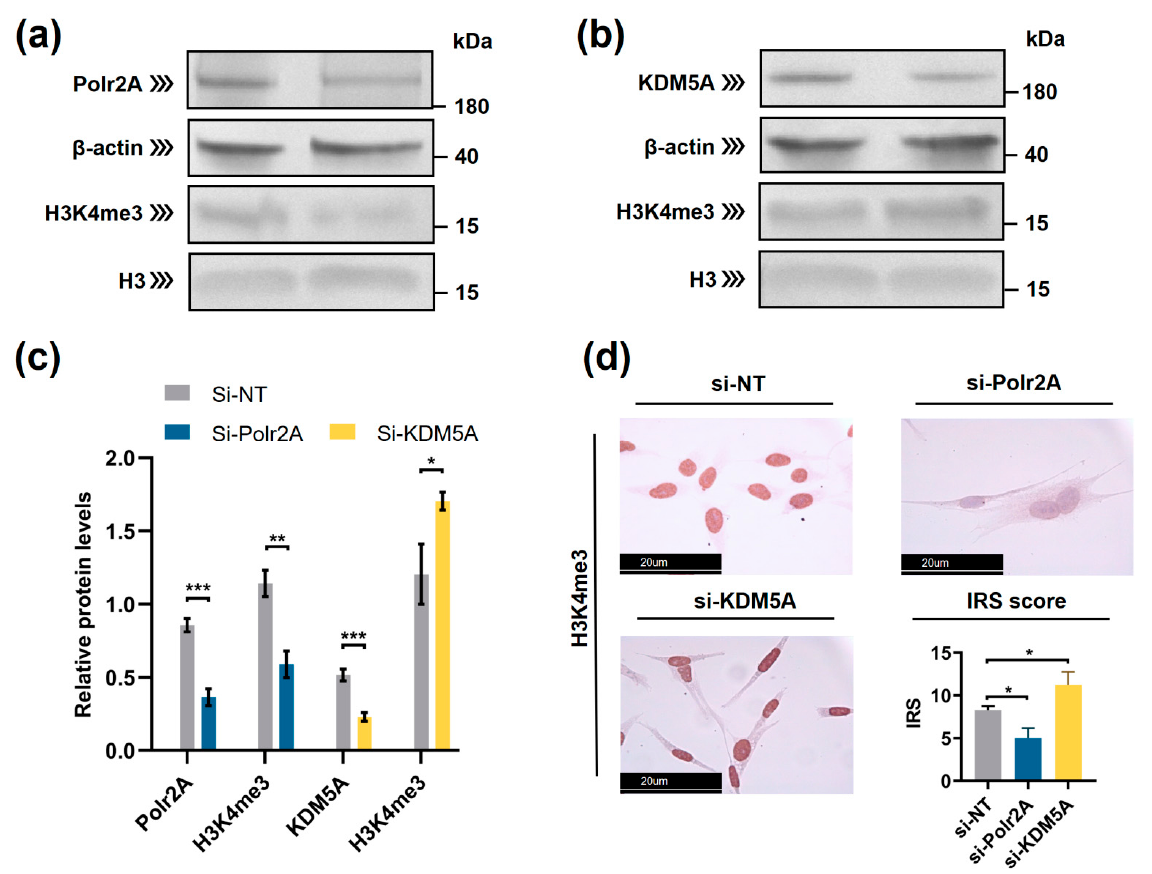
Figure 7. Polr2A and KDM5A regulated global levels of H3K4me3 in HTR-8/SVneo cells. ( a – c ) Western blot analysis and ( d ) immunocytochemistry showed that, compared with si-NT-cells, si-Polr2A-cells showed lower levels of H3K4me3 and si-KDM5A-cells showed higher levels of H3K4me3. In the boxplots, protein levels of Polr2A and KDM5A expressed relative to β -actin levels, protein levels of H3K4me3 expressed relative to histone H3 levels, IRS = staining intensity × percentage of positive cells. Three independent experiments were performed. Data were reported as mean ± SD. Independent samples t -test was used for statistical analysis. H3, Histone H3; si-NT, non-targeting control siRNA; si-Polr2A, siRNA targeting Polr2A; si-KDM5A, siRNA targeting KDM5A. * p < 0.05; ** p < 0.01; *** p < 0.001.